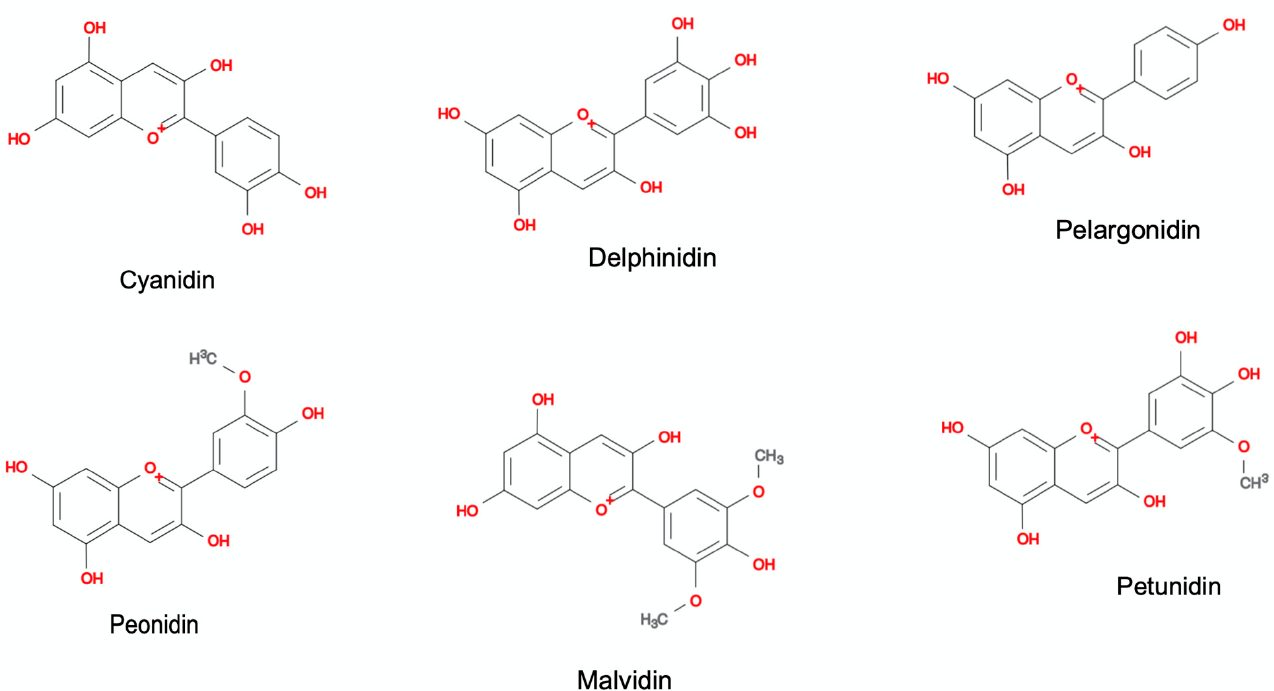
Figure 1. Molecular structure of anthocyanidins (Cyanidin, Delphinidin, Pelargonidin, Peonidin, Malvidin, and Petunidin). The figure was created with Mind the Graph (https://mindthegraph.com (accessed on 11 February 2022)).